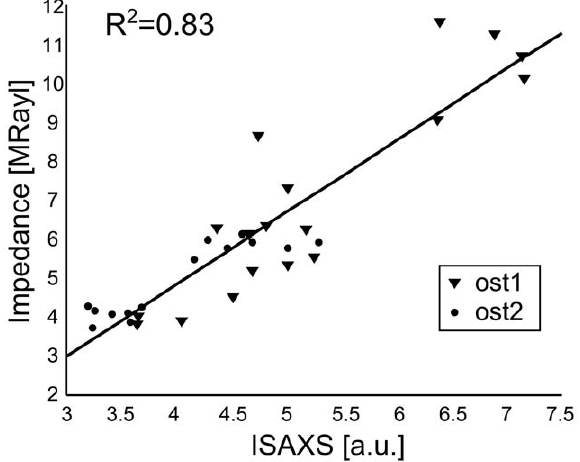
Figure 7. Minima and maxima of acoustic impedance ( Z ) and mineral orientation ( I SAXS ) show a positive correlation (linear regression for the pooled data from ost1 ( . ) and ost2 ( N ).